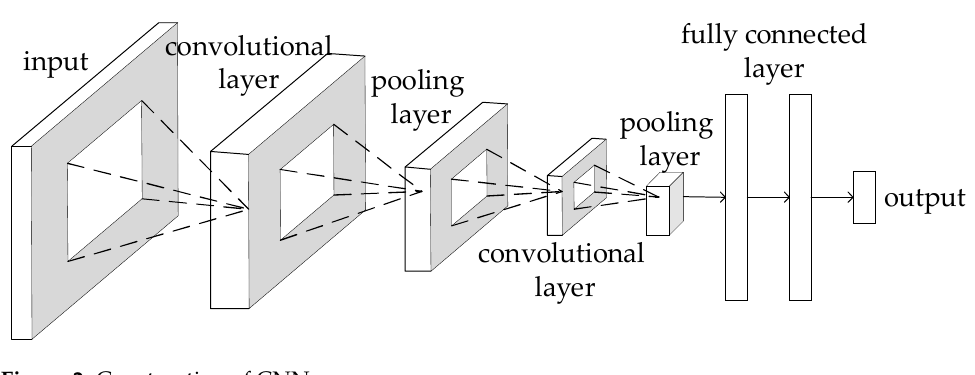
Figure 2. Construction of CNN.